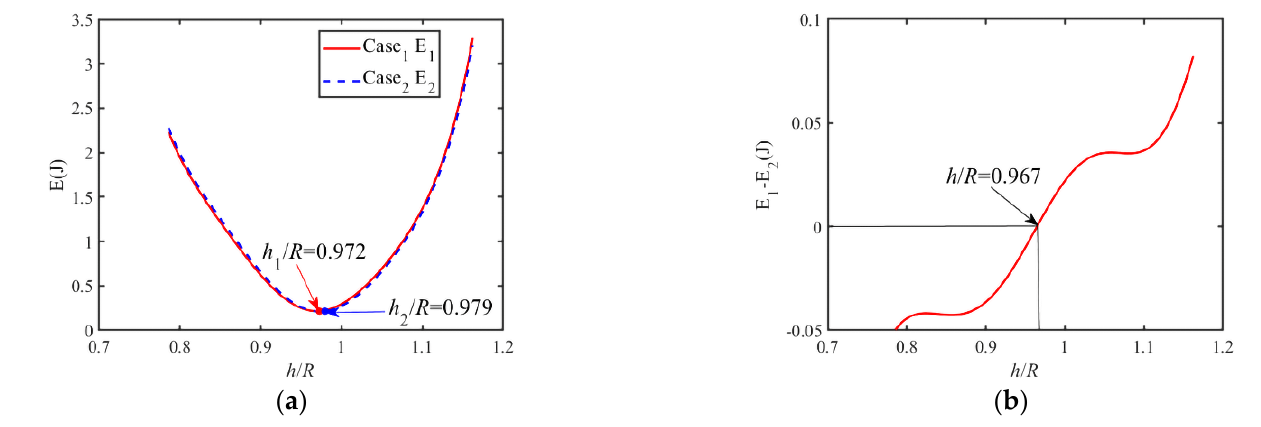
Figure 11 . The variation of energy consumption with the height h of via points. (a) Energy consumption under case 1 and case 2. (b) Energy Consumption Difference under Case 1 and Case 2.